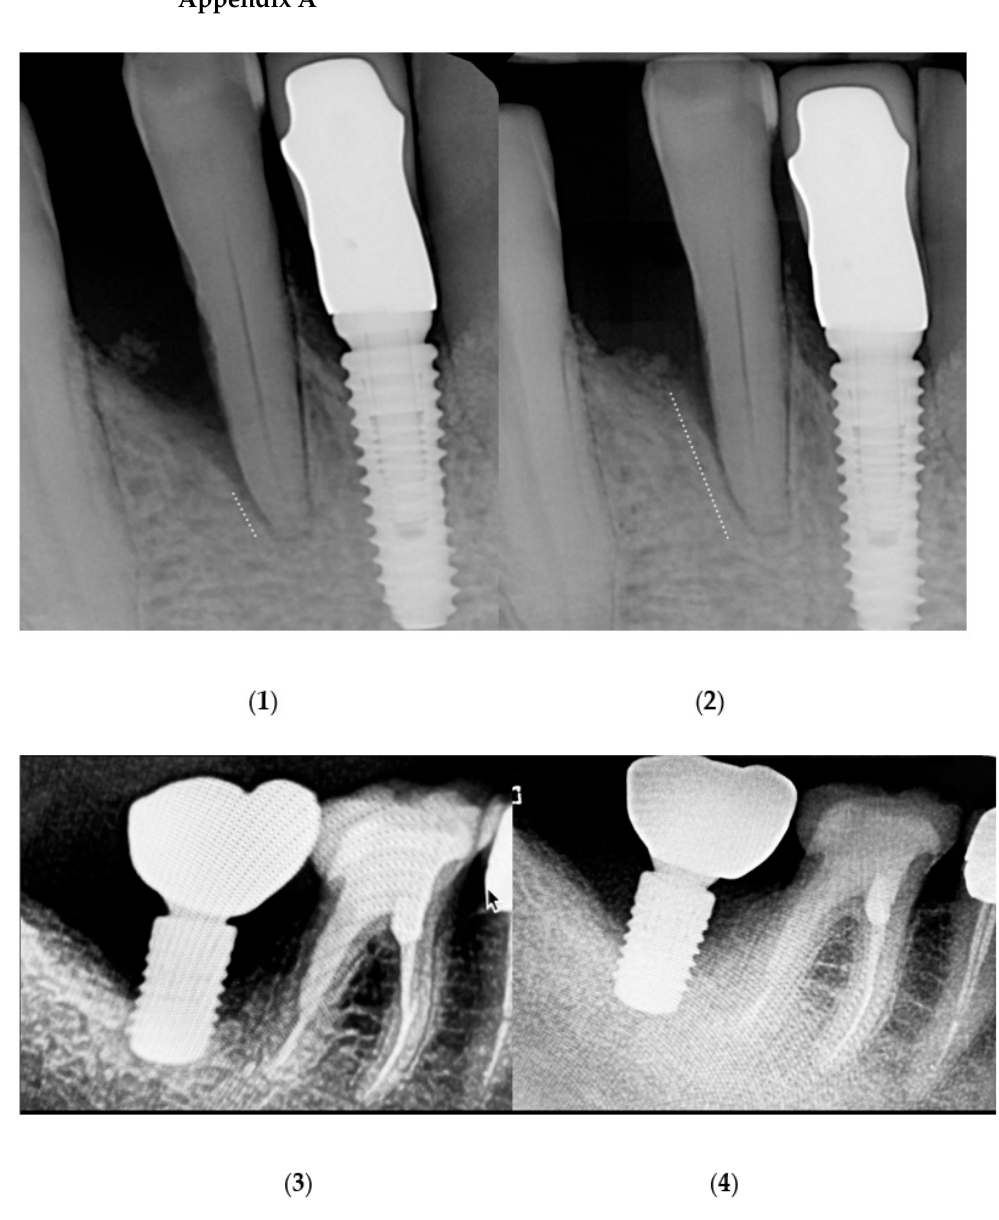
Figure A1. Radiographs before ALAD-PDT treatment ( 1 ) and after ALAD-PDT treatment ( 2 ) in periodontitis sites. Radiographs before ALAD-PDT treatment ( 3 ) and after ALAD-PDT treatment ( 4 ) in peri-implantitis